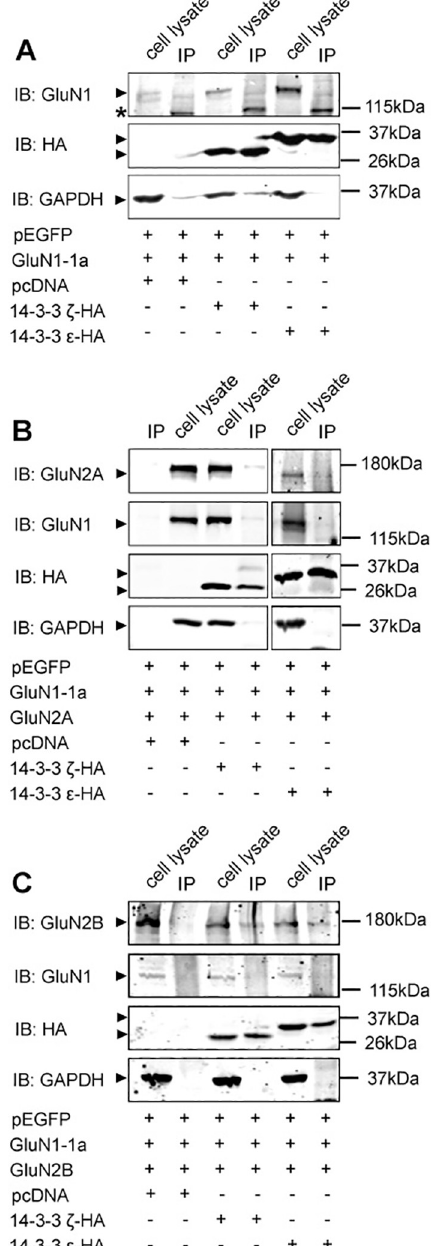
Fig 6. 14-3-3 z and ε interact with GluN2A- and GluN2B-containing NMDARs. tsA201 cells co-expressing NMDAR subunits and HA-tagged 14-3-3 z or ε isoforms were lysed and proteins were immunoprecipitated (IP) with anti-HA antibodies. Input and IP protein samples were separated by SDS/PAGE and probed with NMDAR subunit antibodies. As controls, cell lysates expressing vector control (pcDNA) were used for comparison and all immunoblots were re- probed with anti-HA and anti-GAPDH antibodies. Images shown are representative western blots from three independent experiments. IB, antibody used for immunoblot analysis. A , When GluN1-1a is transiently expressed alone, neither 14-3-3 z nor ε is coimmunoprecipitated from cells expressing either of these 14-3-3 isoforms as compared to cells expressing pcDNA (vector control). � There is a non-specific band detected ~115kDa when probed with anti-GluN1 antibody. B , 14-3-3 z and ε coimmunoprecipitate both GluN1 and GluN2A subunits from cells expressing functional GluN2A subunits, which do not coimmunoprecipitate from cells only expressing pcDNA. C , Cells expressing functional GluN2B subunits result in coimmunoprecipitation of both GluN1 and GluN2B subunits from cells expressing 14-3-3 z or ε isoform, which does not result from cells expressing only pcDNA.